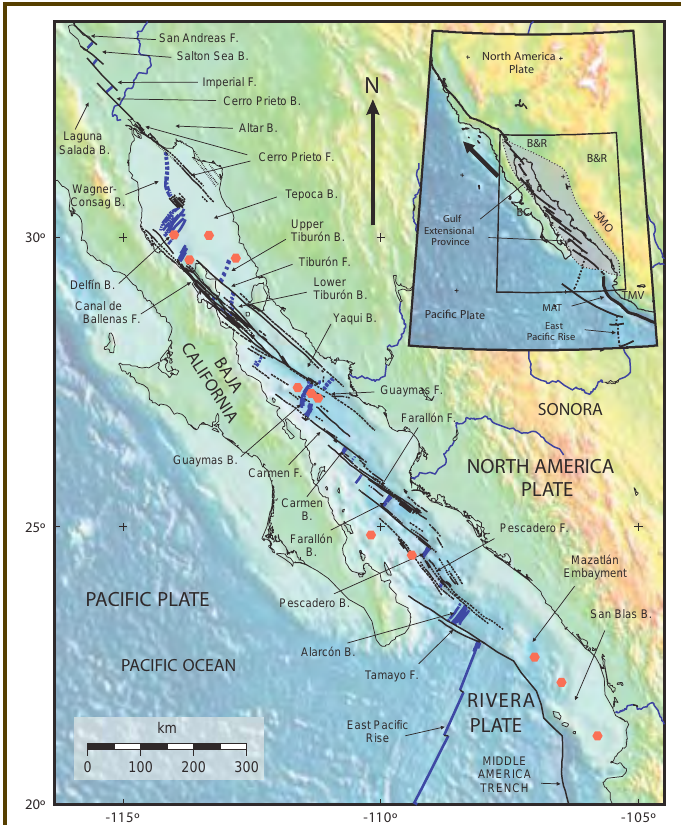
Figure 4. Tectonic map with digital elevations of the Gulf of California region, modified from Aragón-Arreola (2006). This region hosts the modern transtensional boundary between the Pacific and North America plates, comprising spreading centers or extensional basins (blue lines) and faults (black lines). Modern and abandoned basins of the plate boundary are labeled. Red dots show proposed IODP sites. Abbreviations: F=fault, B=basin. Inset: regional map of plate boundary system. Inset abbreviations: SMO=Sierra Madre Occidental; B&R = Basin and Range Province; BC=Baja California; TMV=Trans-Mexican Volcanic Belt; MAT=Middle America